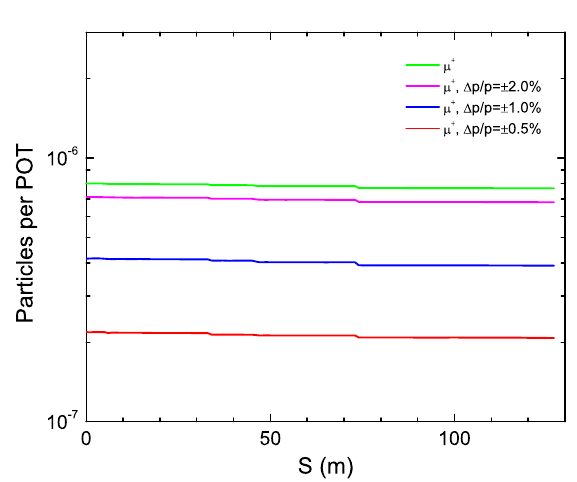
FIG. 7. The simulated performance along the M4-and M5-line, where the evolution of muons is given as a function of distance along the channel for different momentum